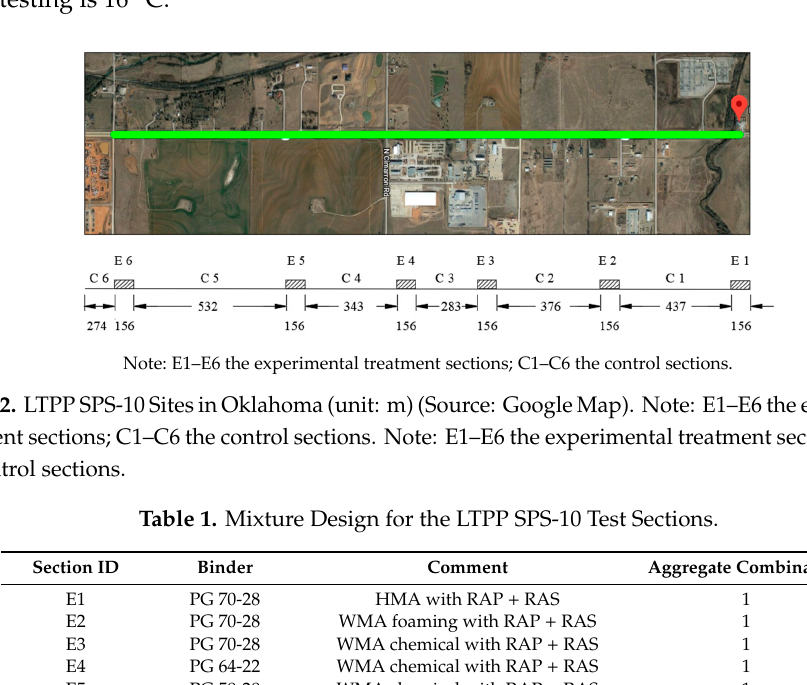
Figure 1. Flowchart to determine interface friction.